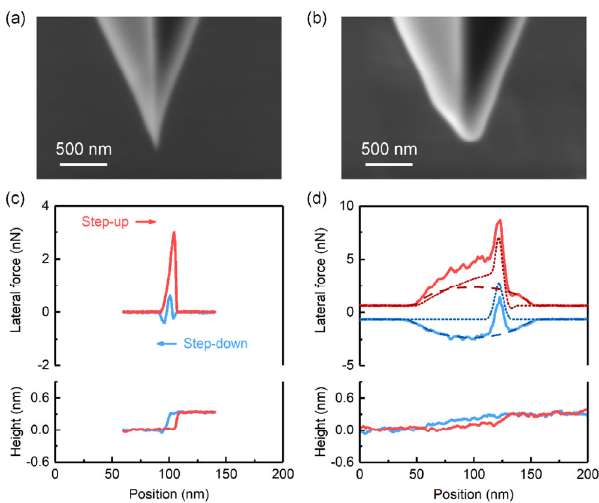
Fig. 3 Effect of tip bluntness on the lateral signal at the graphene step edge. Front view SEM images of (a) sharp and (b) blunt tips used for the experiment. Lateral signals and height profiles obtained with the (c) sharp and (d) blunt Si tips at an applied normal load of about 20 nN. The data collected during step-up motion is plotted in red color, and the data collected in step-down motion is plotted in blue color. The lateral signal shown in (d) are deconvoluted into two components, referring to chemical components (dash-lines) and topographical components (dot-lines),